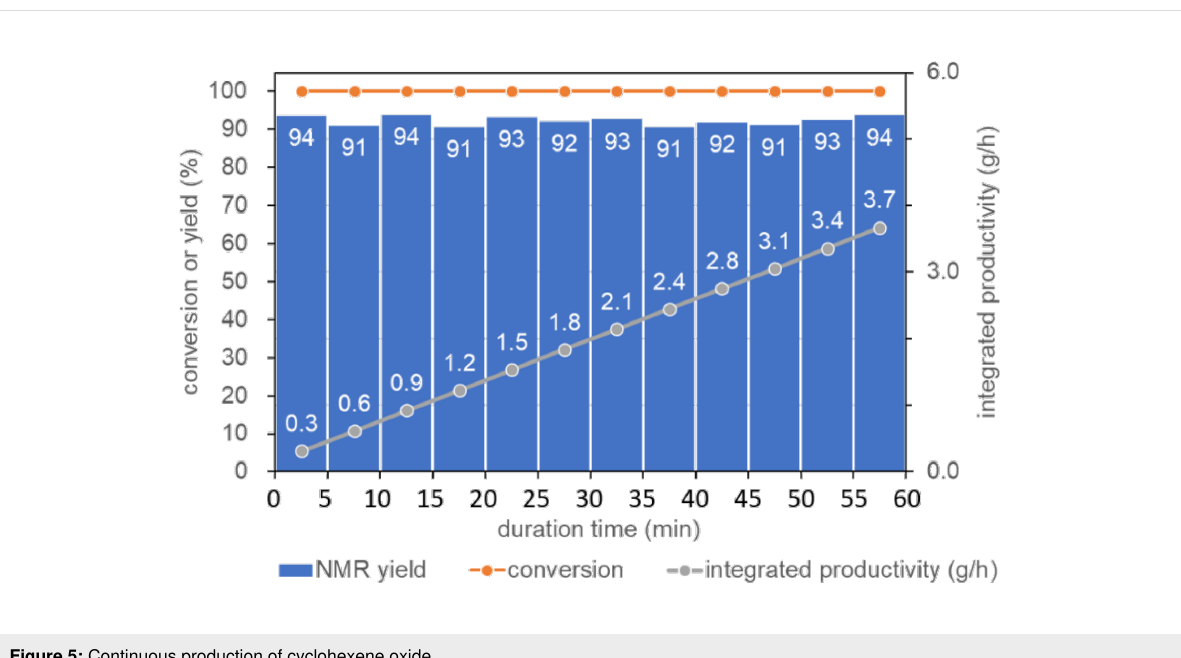
Figure 5: Continuous production of cyclohexene